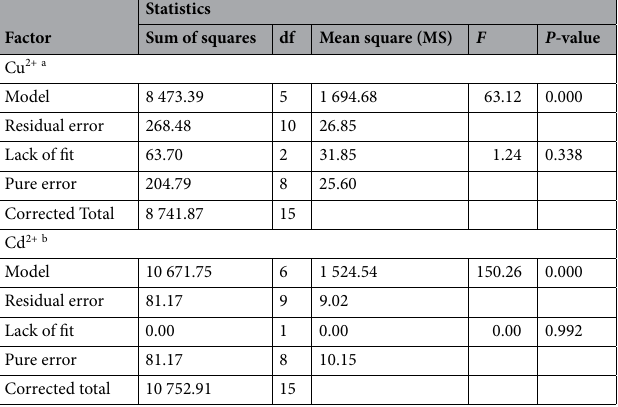
Table 6. Analysis of variance-reduced models fitting for Cu 2+ and Cd 2+ . a R 2 = 0.97 (adjusted R 2 = 0.95). b R 2 = 0.99 (adjusted R 2 =